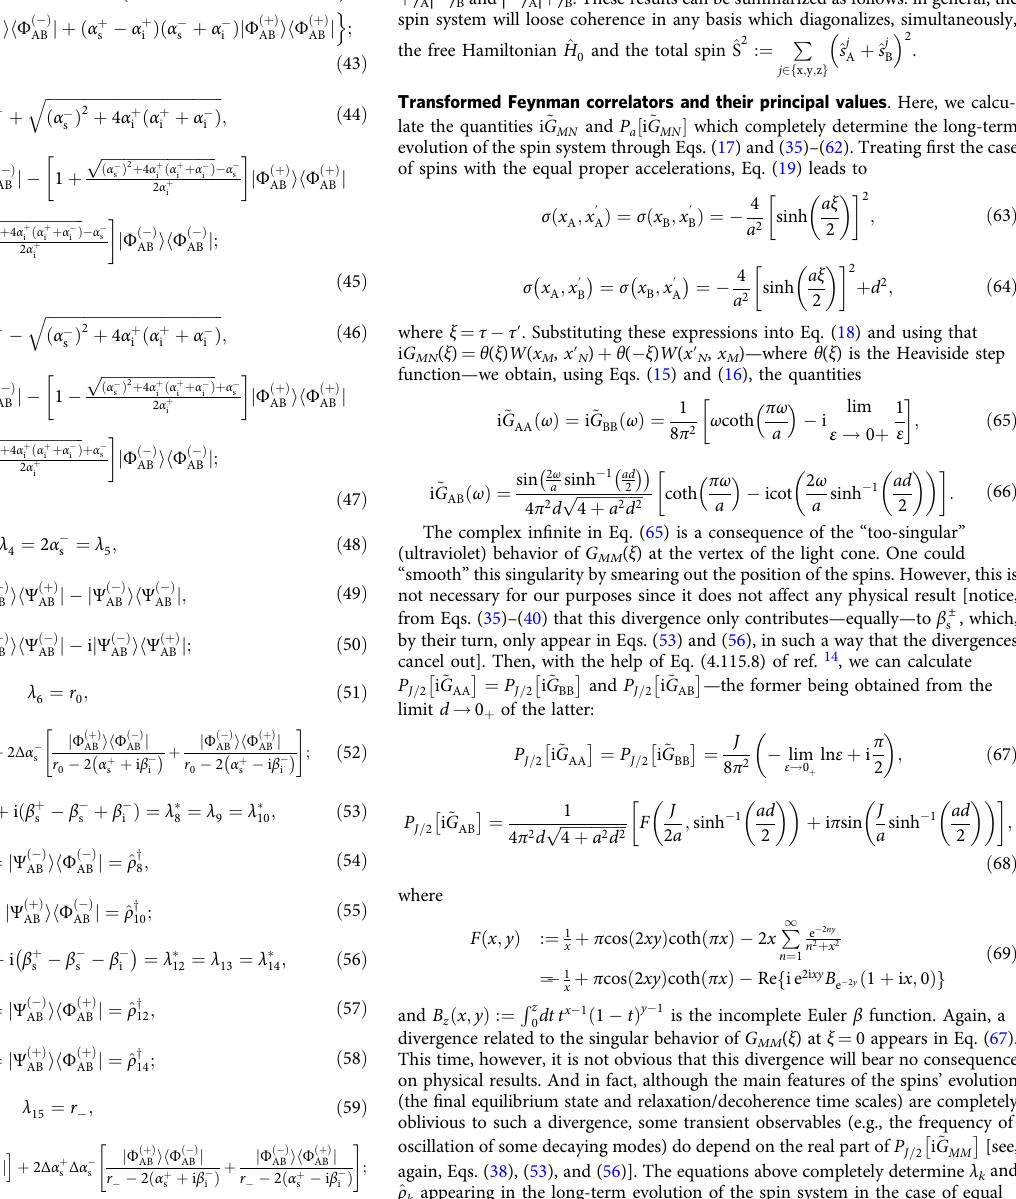
ffiffiffiffiffiffiffiffiffiffiffiffiffiffiffiffiffiffiffiffiffiffiffiffiffiffiffiffiffiffi p ð α (cid:2) s Þ 2 þ 4 α þ i ð α þ i þ α (cid:2) i Þ